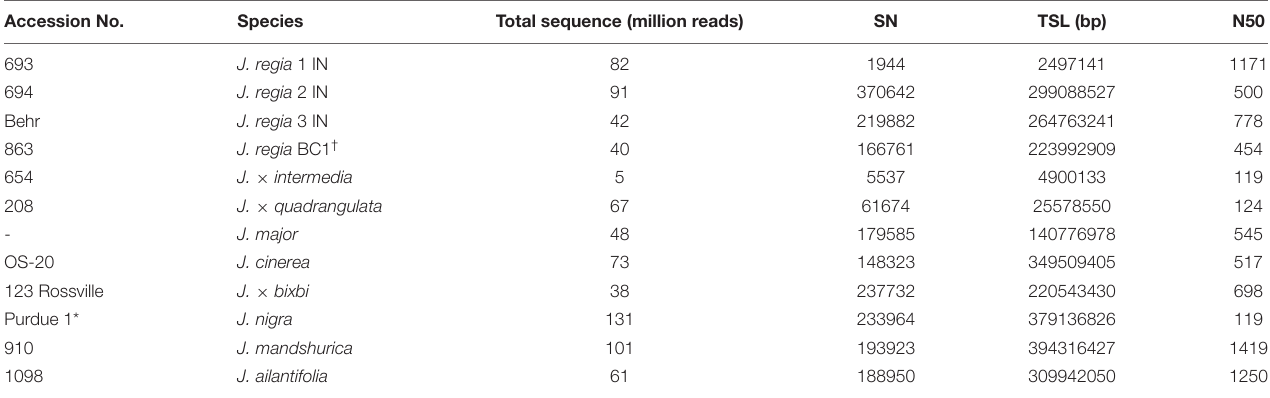
TABLE 2 | Accession number, species, total sequence reads and assembly statistics for the 12 Juglans species used for evaluation of cold hardiness genes. Accession No.